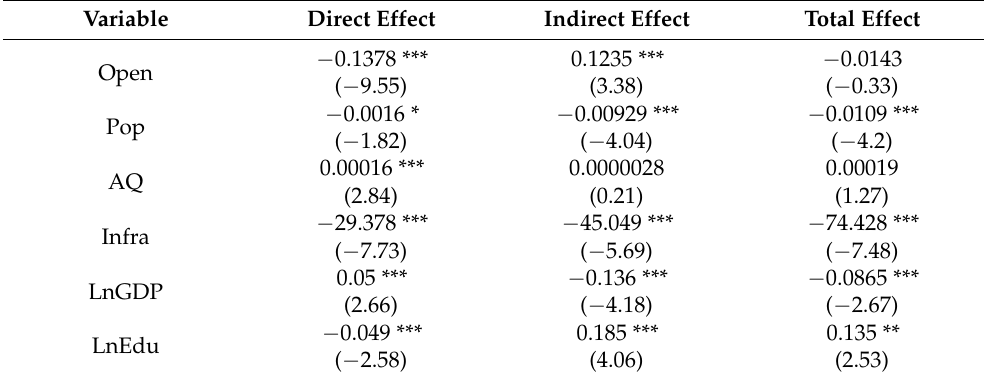
Table 7. Spatial effect decomposition of